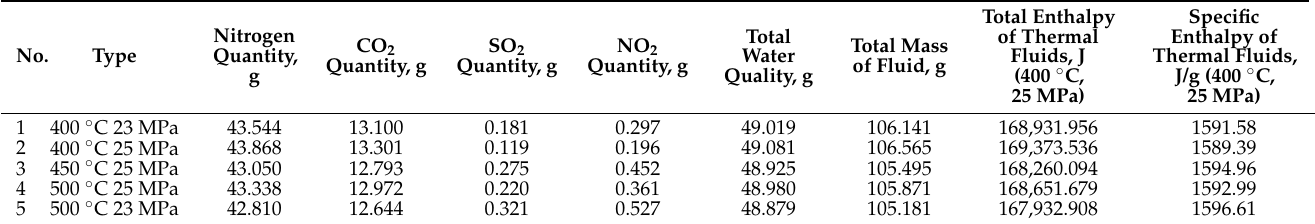
Table 12. Enthalpy of supercritical multi-thermal fluid generated by supercritical water–crude oil reaction under different initial temperature and pressure